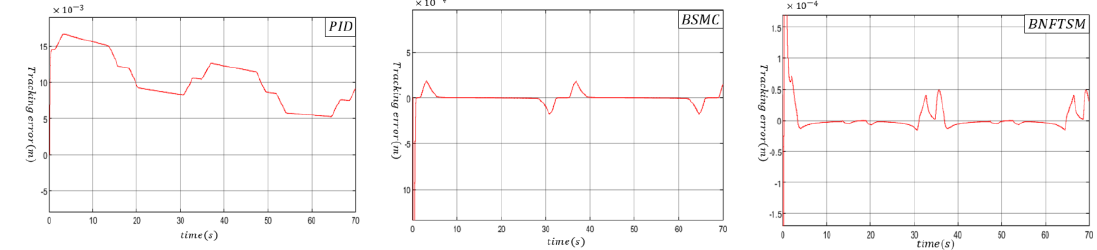
Figure 4. Tracking error curves of three controllers under 4000N constant load force.